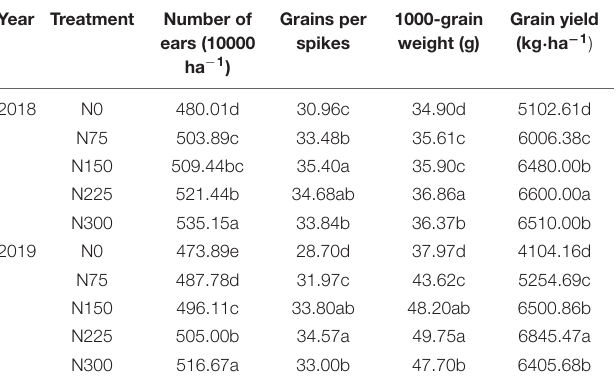
TABLE 6 | Effect of nitrogen (N) application rates on number of ears per hectare, grains per spike, 1000-grain weights, and grain yield of winter wheat during 2018 and